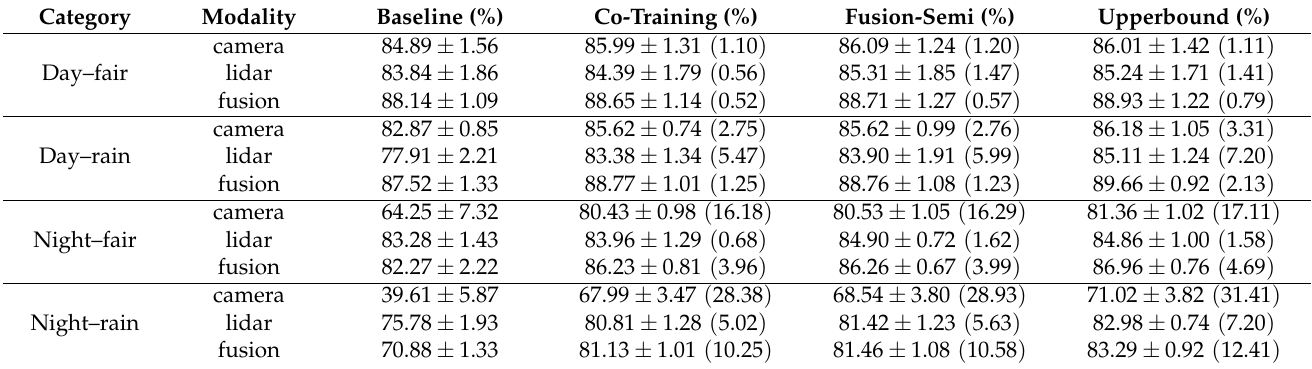
Table 3. Main results showing the vehicle class average IoU in percentage, and standard deviation on the test sets (see Section 4.2). The numbers within parentheses denote the average improvement with respect to the supervised